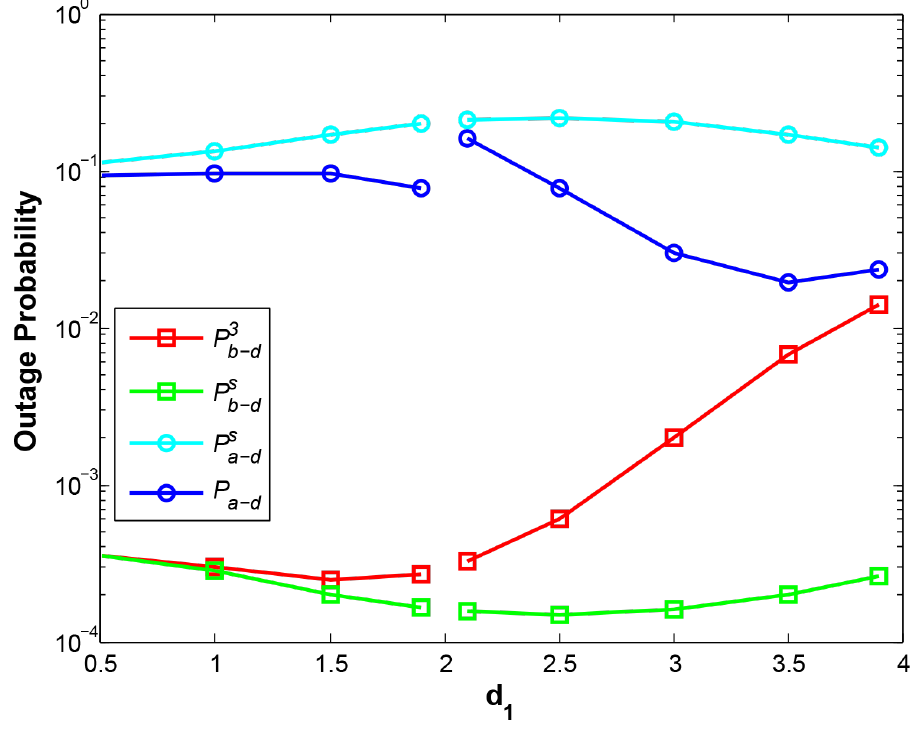
Figure 9. OP vs. d 1